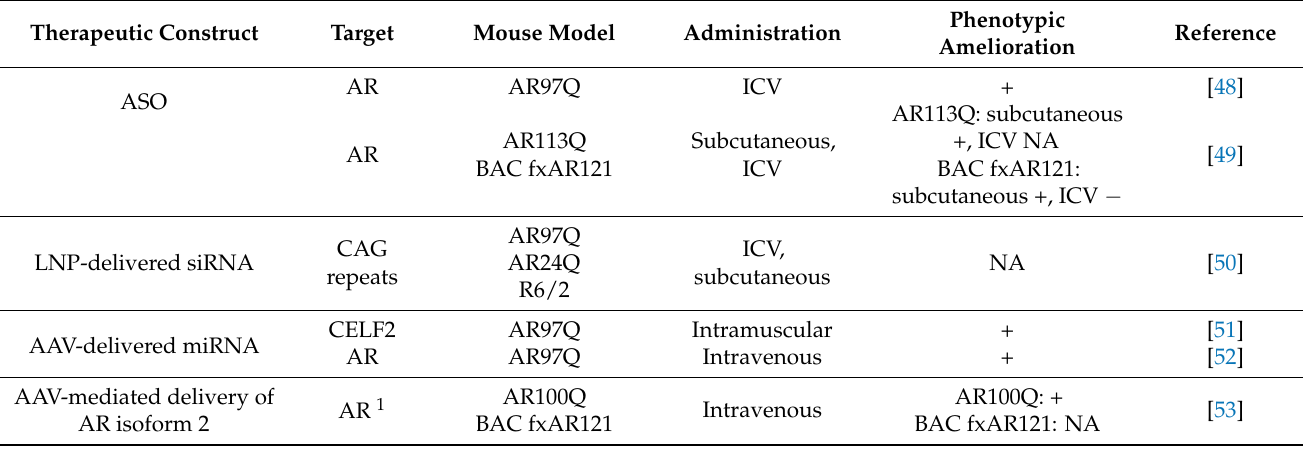
Table 2. Studies of nucleic acid-based therapeutic approaches in SBMA.